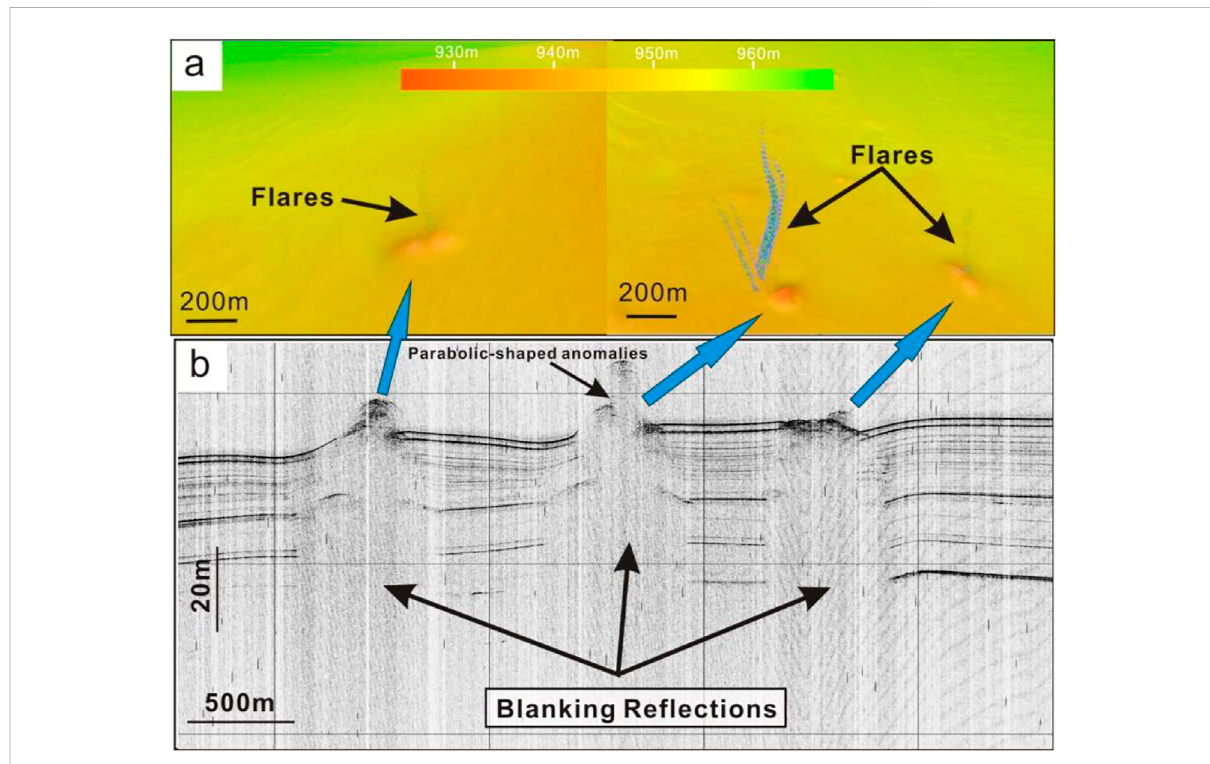
FIGURE 10 Multibeam and sub-bottom pro fi le data show domes. (A) Bathymetry data show fl ares above domes. (B) The sub-bottom pro fi le data show parabolic-shaped anomalies above domes. See locations in Figure